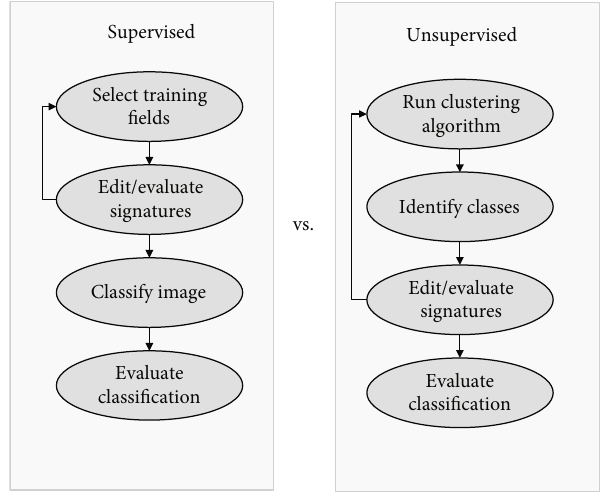
Figure 1: Comparison of unsupervised image classi fi cation and supervised image classi fi cation